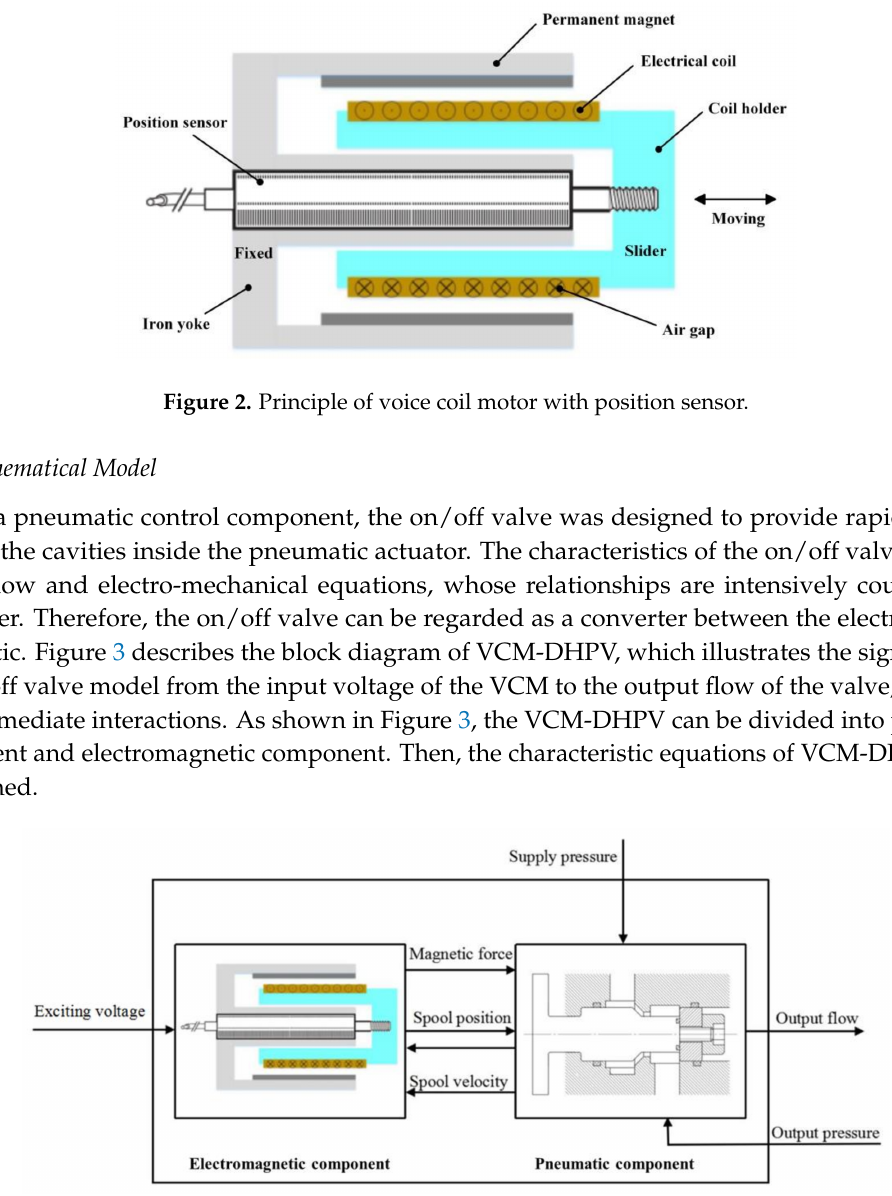
Figure 3. Block diagram for mathematical model of